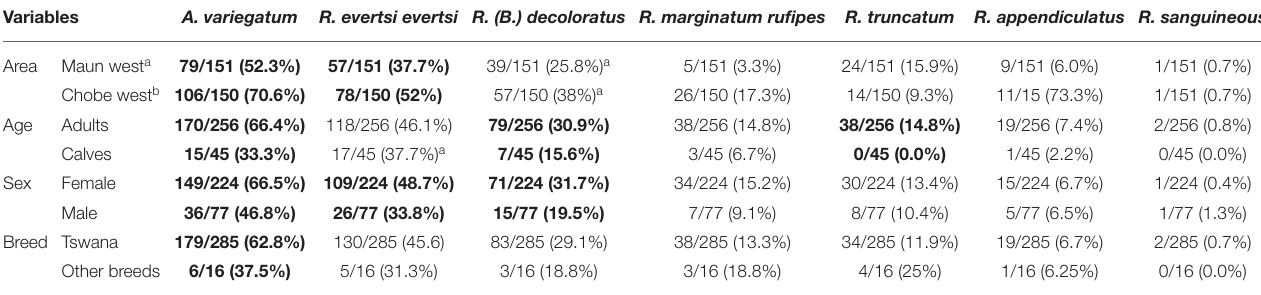
TABLE 1 | A comparison of ixodid tick species prevalence (%) per area, age, sex, and breed at the wildlife-livestock interface areas in northern Botswana (Maun west and Chobe west). Variables A. variegatum R. evertsi evertsi R. (B.) decoloratus R. marginatum rufipes R. truncatum R. appendiculatus R. sanguineous